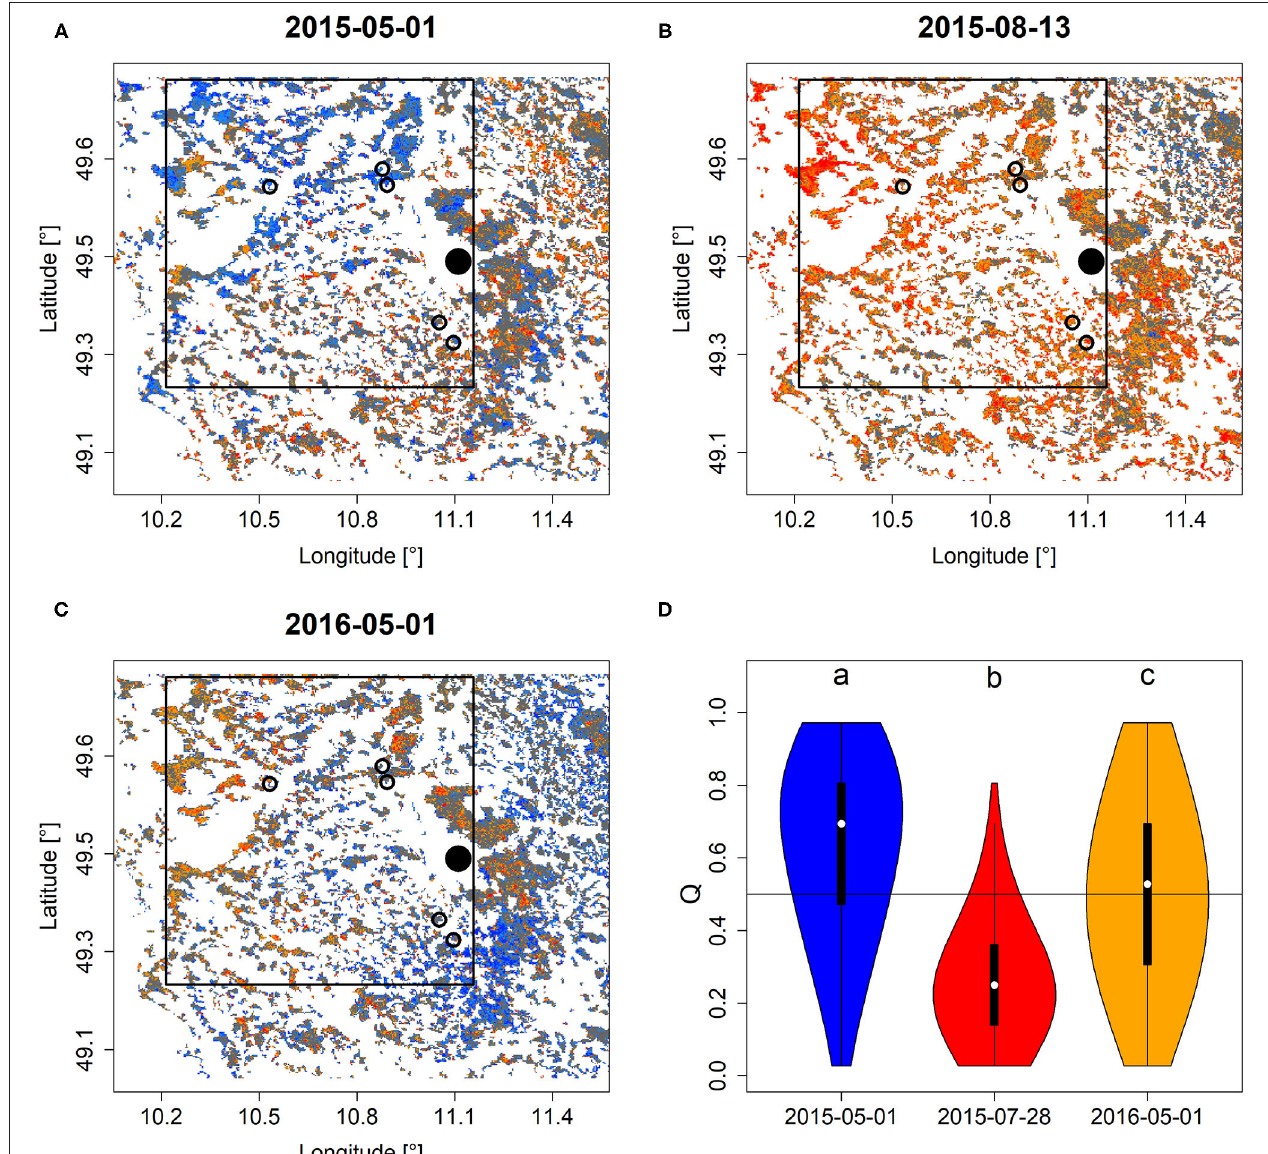
FIGURE 3 | Q mapped for the area surrounding Nuremberg (black dot) before (A) , during (B) , and after (C) the extreme drought of 2015. Circles refer to study sites investigated in Buras et al. (2018), in which tree die-back was observed early in 2016. The black rectangle roughly refers to the study area of Buras et al. (2018) for which Q was extracted to generate (D) which depicts violin plots of Q -values of the three corresponding dates of pixels within this rectangle that feature Scots pine cover of more than 70 percent. Minor case letters in (D) refer to group-assignments according to Wilcoxon rank-sum test. A similar figure but for PDM is shown in Supplementary Figure 4